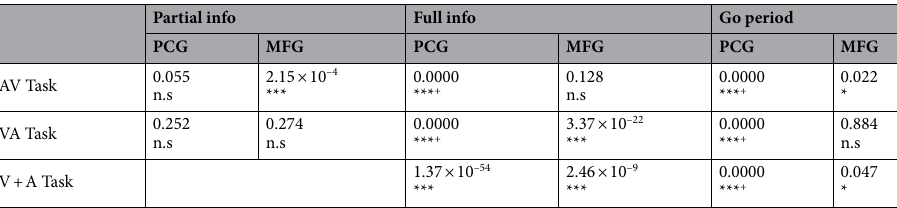
Table 1. KW test p-values for comparison of SSIMS distance distributions. n.s., not significant; *, p < 0.05; ***, p < 0.001; *** + , p -value < 1 x 10 -300 (minimum floating point accuracy in